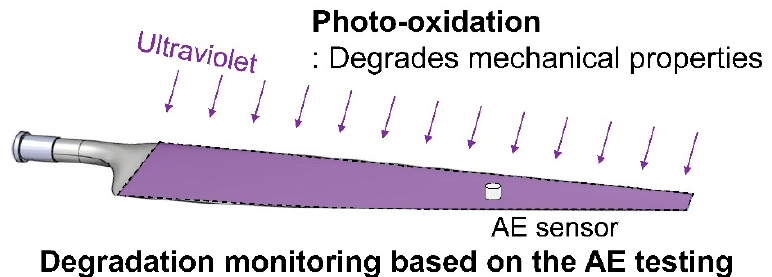
Figure 1. Schematic illustration of this research.